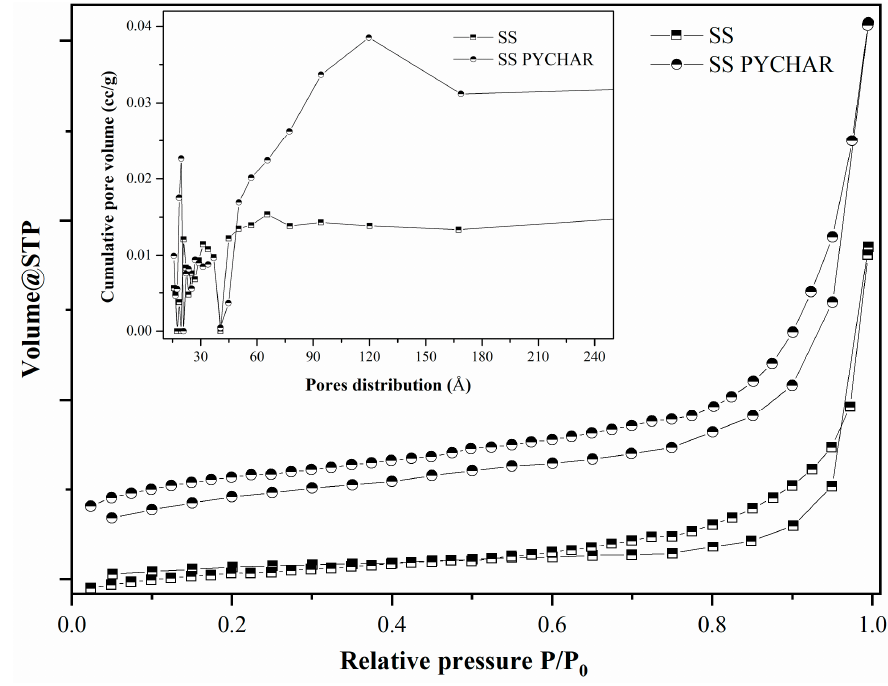
Figure 4. Adsorption isotherms and pore distribution for sewage sludge (SS) and SS PYCHAR. Table 4. Textural properties of the materials based on sewage sludge